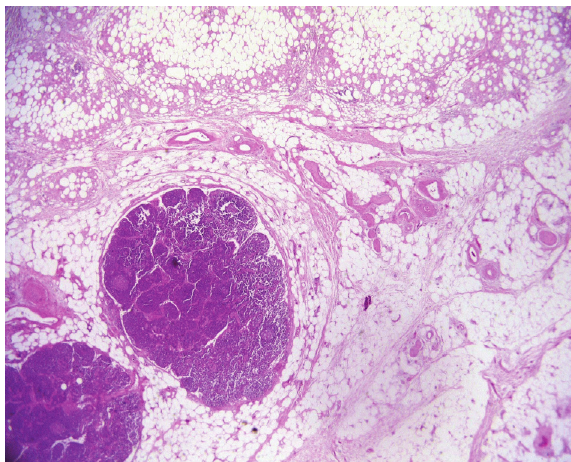
Figure 3: Idiopathic retractile sclerosing mesocolitis: aspecific reactive lymphadenopathy of pericolic nodes and lipophagic inflammation of mesocolon (emathoxilyn-eosin 100x original